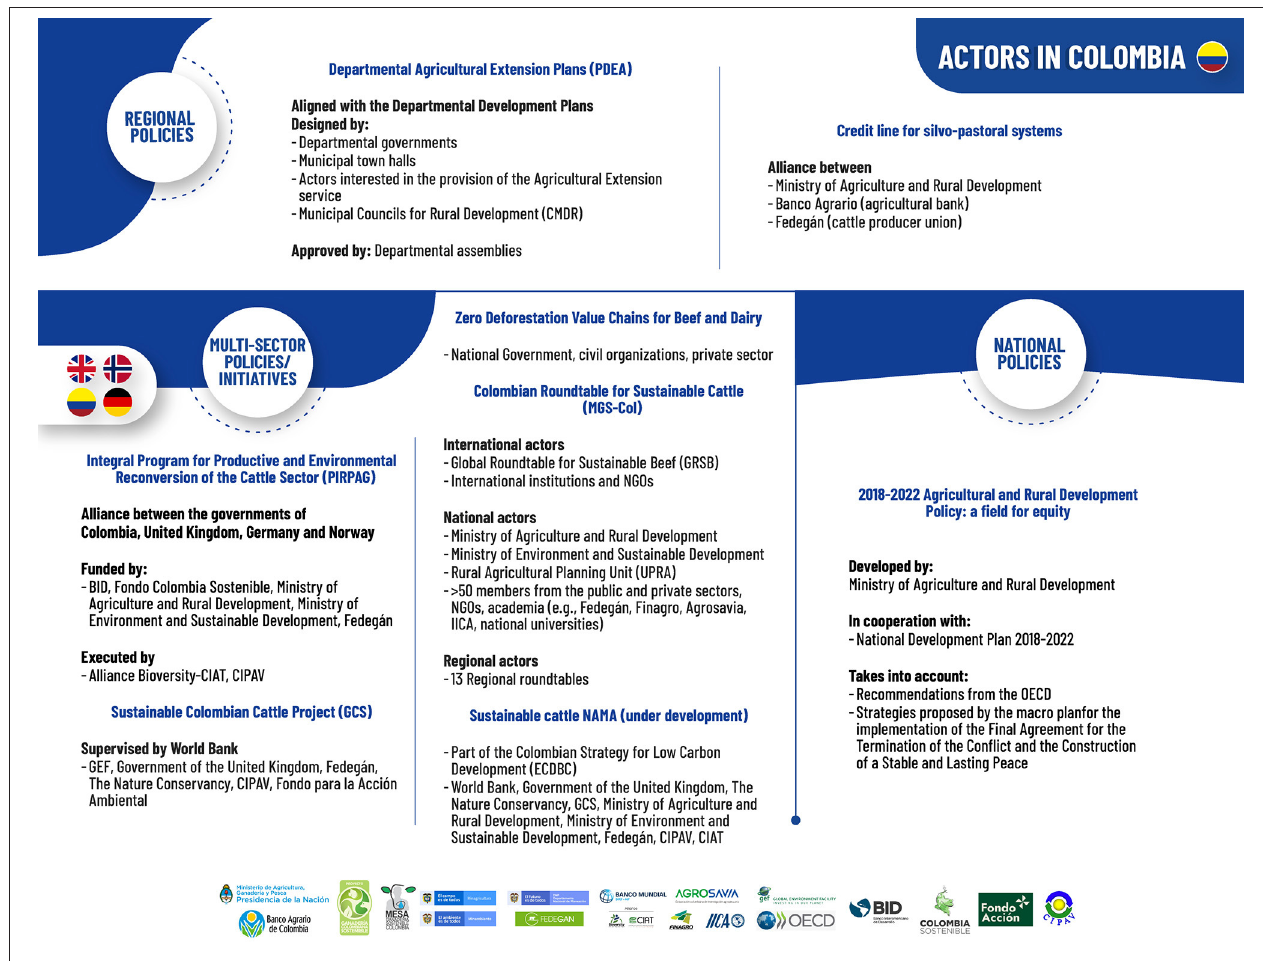
FIGURE 1 | Actors involved in the design and execution of public policies in Colombia.